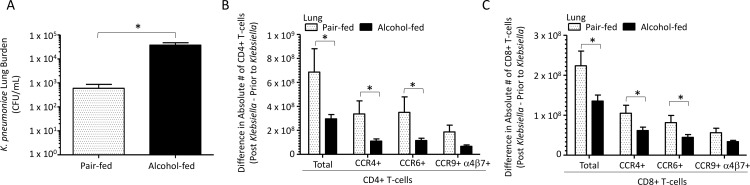
Binge-on-chronic alcohol use increases host susceptibility to Klebsiella pneumoniae in mice.(A) Klebsiella lung burden (CFU/ml) at 48 hrs. post infection in pair-fed and binge-on-chronic alcohol treated mice. (B) Difference in absolute number of homing receptor positive lung CD4+ T-cells isolated 48 hrs. post-Klebsiella infection from values obtained pre-infection in alcohol-fed and pair-fed mice. (C) Difference in absolute number of homing receptor positive lung CD8+ T-cells 48 hrs. post-Klebsiella infection from values obtained pre-infection in alcohol-fed and pair-fed mice. Bars represent the mean of the cell counts post infection minus the cell counts prior to infection ± SEM. * indicates P < 0.05, by Mann-Whitney U or by ANOVA with Dunn’s correction. N = 10/group.